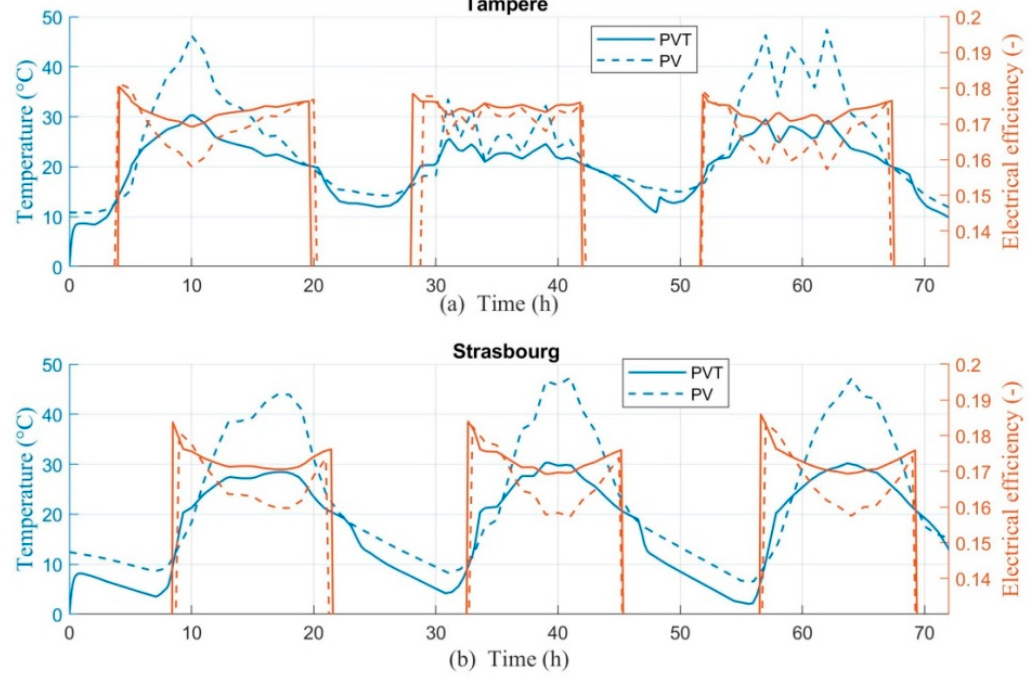
Figure 10. The PV cell operating temperatures and electrical efficiency ( a ) in Tampere and ( b ) in Strasbourg during the three summer days.